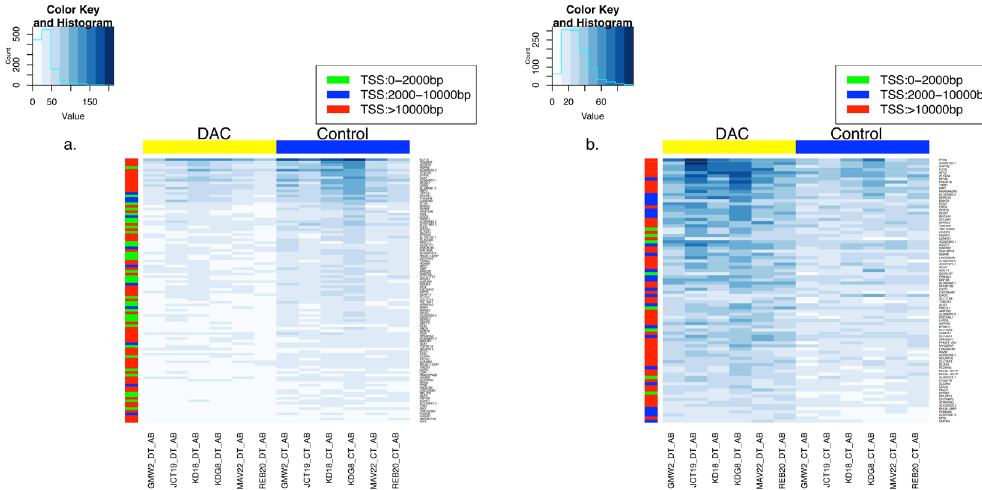
Figure 4. Heatmaps showing the global changes in H3K9 acetylation in AML patient samples treated with DAC. Purified mononuclear cells from bone marrow samples from six AML patients were treated with DAC 500 nM for 72 h and H3K9 acetylation was analyzed by ChIP-Seq as described under methods. The right panel (a) shows the panel of the 102 genes showing H3K9 acetylation decrease after DAC treatment and the left panel (b) shows the panel of the 85 genes showing H3K9 acetylation increase after DAC treatment. The colored scale at the right of the heatmap shows the position of acetylation change relative to the Transcription Start Site (TSS). The histogram inset at the top shows the value (read count of the peaks) against the count (the number of times those read counts are observed in the